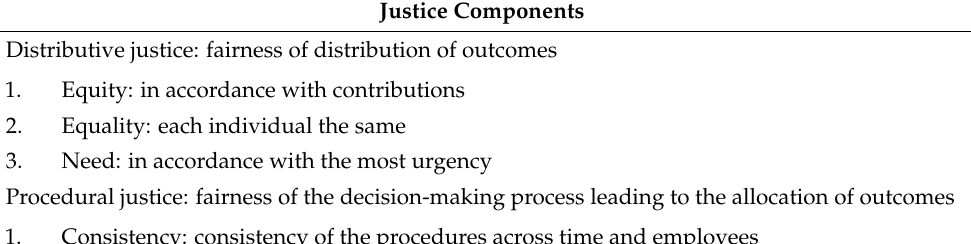
Table 1. Overview of the three justice components with the associated rules. Justice